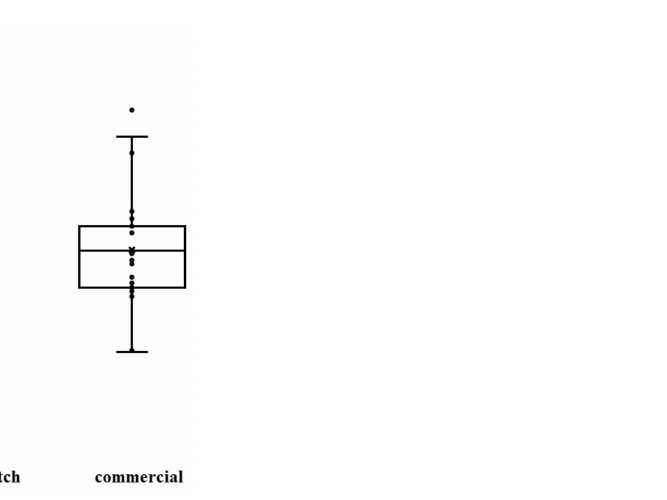
Figure 8. Percentage of the erythema index (%EI) of skin after a 24-h application of the drug-loaded patches and the commercial patches.